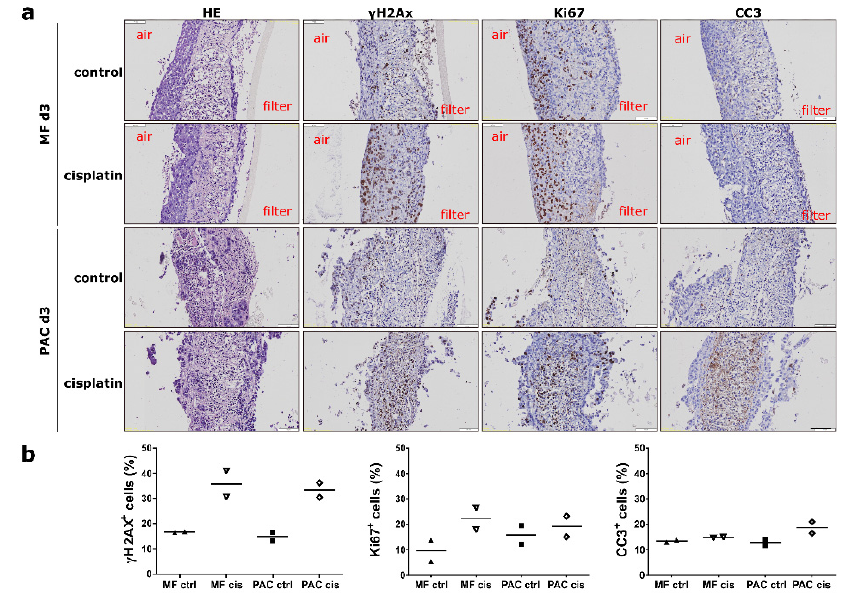
Figure 8. Cisplatin treatment of H1437 CDX tumor slices. ( a ) The tumor slices were incubated with cisplatin for 3 days in both the Millipore filter (MF) system and the perfusion air culture (PAC) system. Compared to the untreated control group (control), the cisplatin-treated tumor slices (cisplatin) cultured in the MF showed the accumulation of γ H2AX and Ki67 at the air interface. The expression of cleaved-caspase 3 (CC3) was not observed after cisplatin treatment in the MF system. After cisplatin treatment, CC3, γ H2AX, and Ki67 were induced in the middle of the tumor slices in the PAC system. The effects of cisplatin in the tumor slices were higher in the PAC system compared to the MF system. The scale bar represents 100 µ m. ( b ) Quantification data of the percentage of positive cells expressing γ H2AX, Ki67, and CC3 in the MF and PAC systems with cisplatin treatment from two mice experiments. In the figures, each shape of the symbol represents one mouse